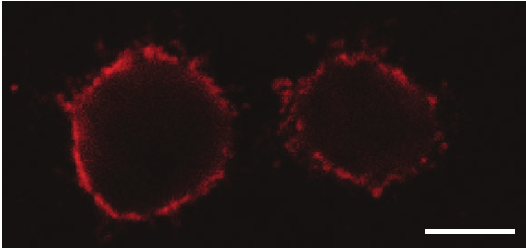
Figure 3. Enzymatically untreated HeLa cells embedded in polyacrylamide gels release glycan structures. Confocal images of HeLa cells embedded in polyacrylamide gel. The peripheral cellular glycans are stained with Ricinus Communis Agglutinin I. Scale bar is 5 m m.